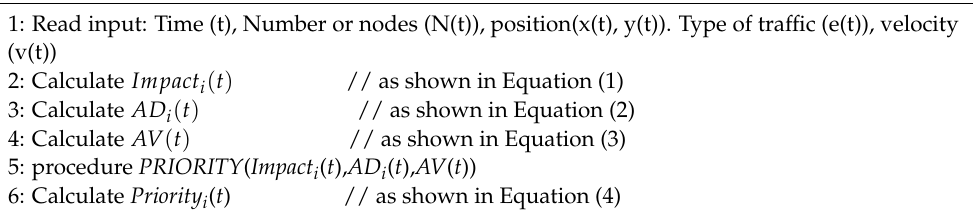
Algorithm 2: Priority or an event message at a node for an instant t